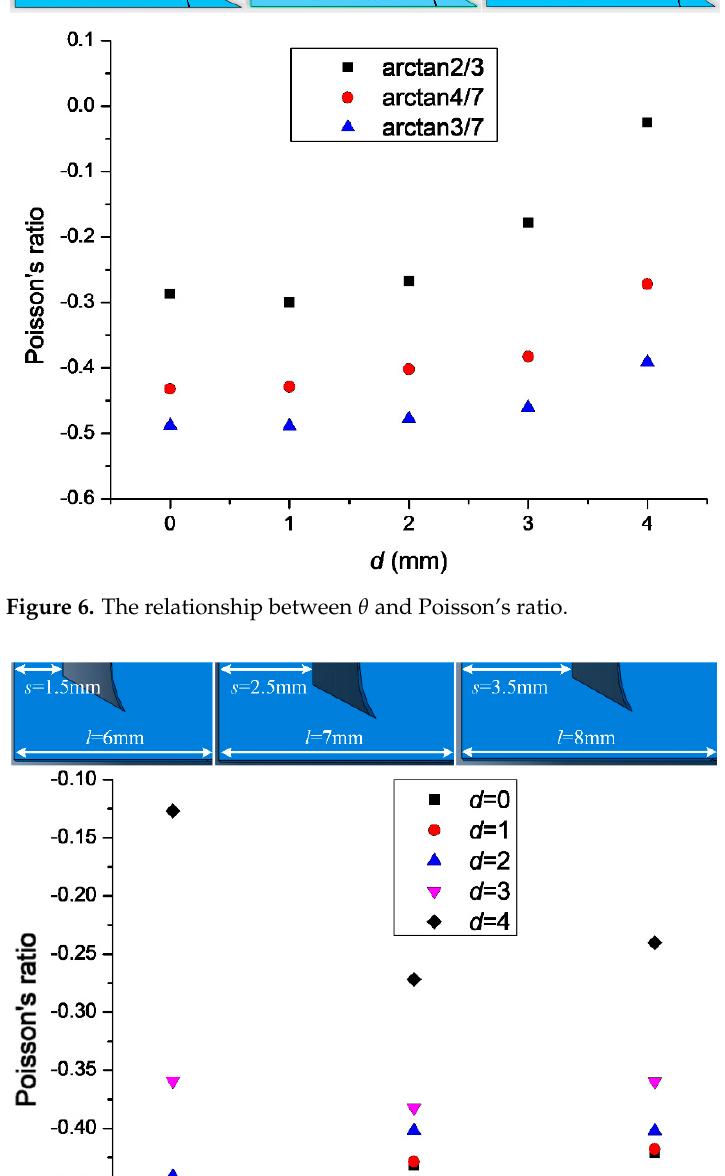
Figure 8. Relationship between the mesh size and Poisson’s ratio using the model with the hollow circle diameter d = 1 as an example.